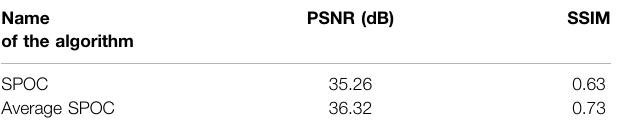
TABLE 1 | Comparison of PSNR and SSIM values of the two algorithms. Name of the algorithm